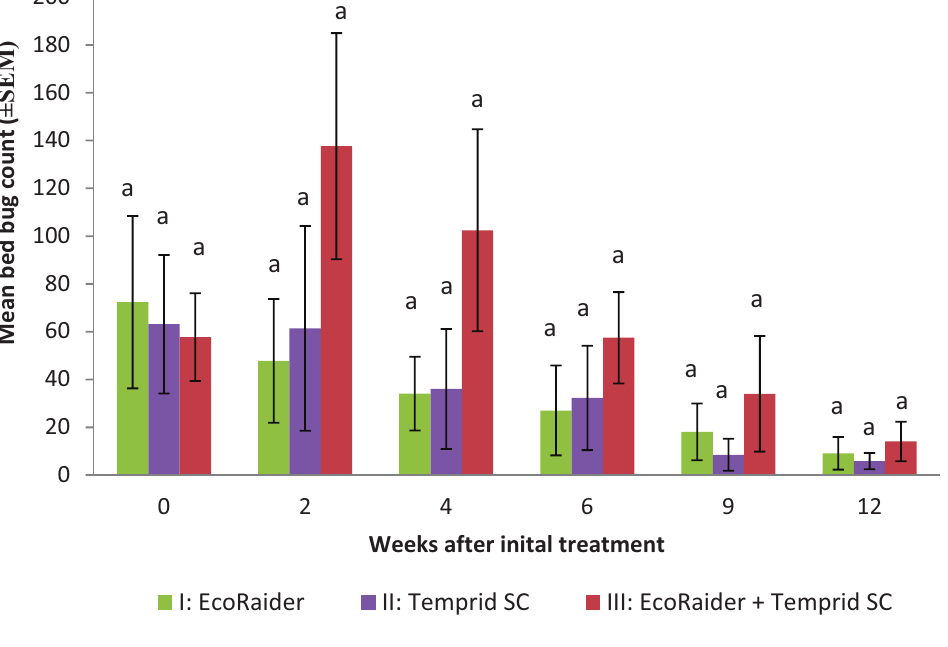
Figure 1. Bed bug counts in apartments before and after three different treatments. Means within the same observation period with same letters are statistically not different (ANOVA, p > 0.05).